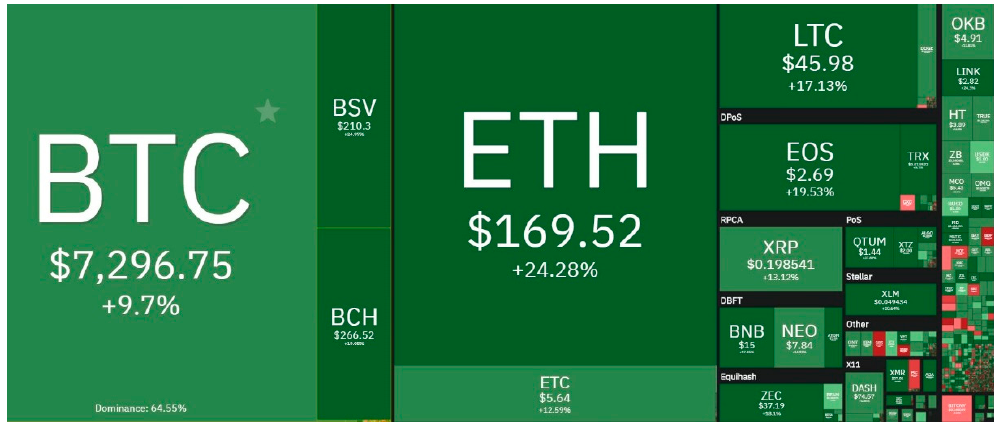
Figure 2. The share of cryptocurrencies in the world market in 2020. Source: coinhouse.com. In terms of 24 h purchase volume, on May 2020, the ranking was slightly different, with Bitcoin ranking second under Tether with 56.16 trillion U.S. dollars (Figure 3).